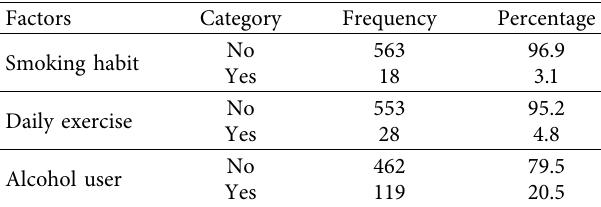
Table 4: Lifestyle factors of hypertensive patients attending at chronic follow-up clinic at Northwest Ethiopia referral